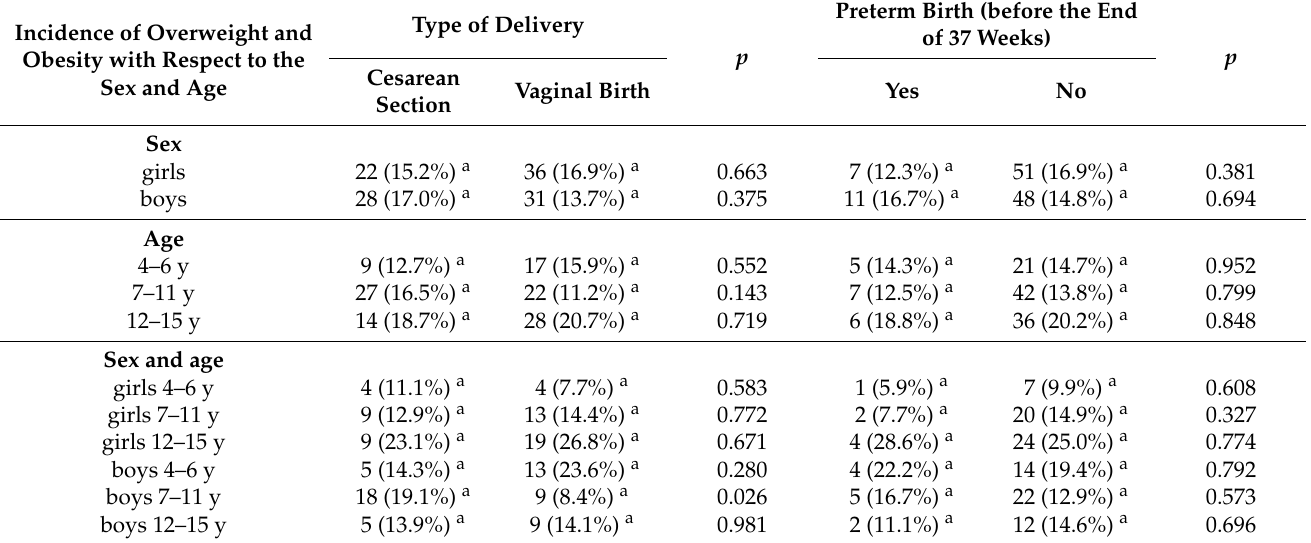
Table 4. Incidence of overweight and obesity depending on the type of delivery and preterm birth, with respect to the sex and age of the subjects.